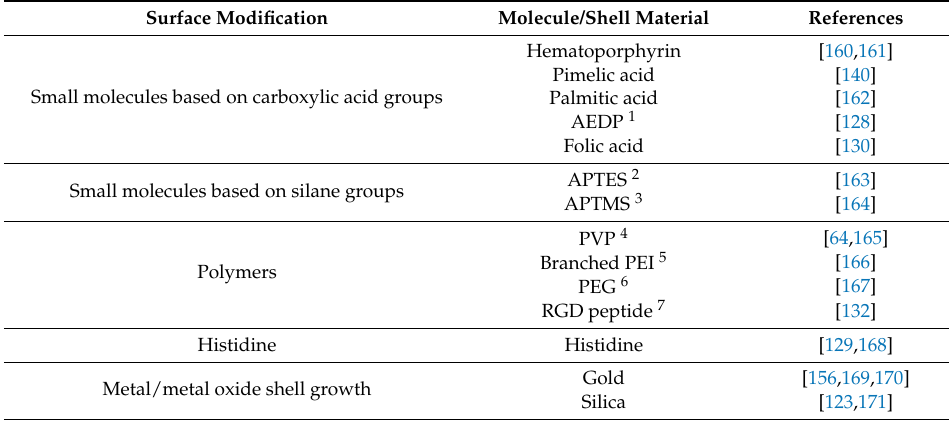
Table 2. Summary of surface modification